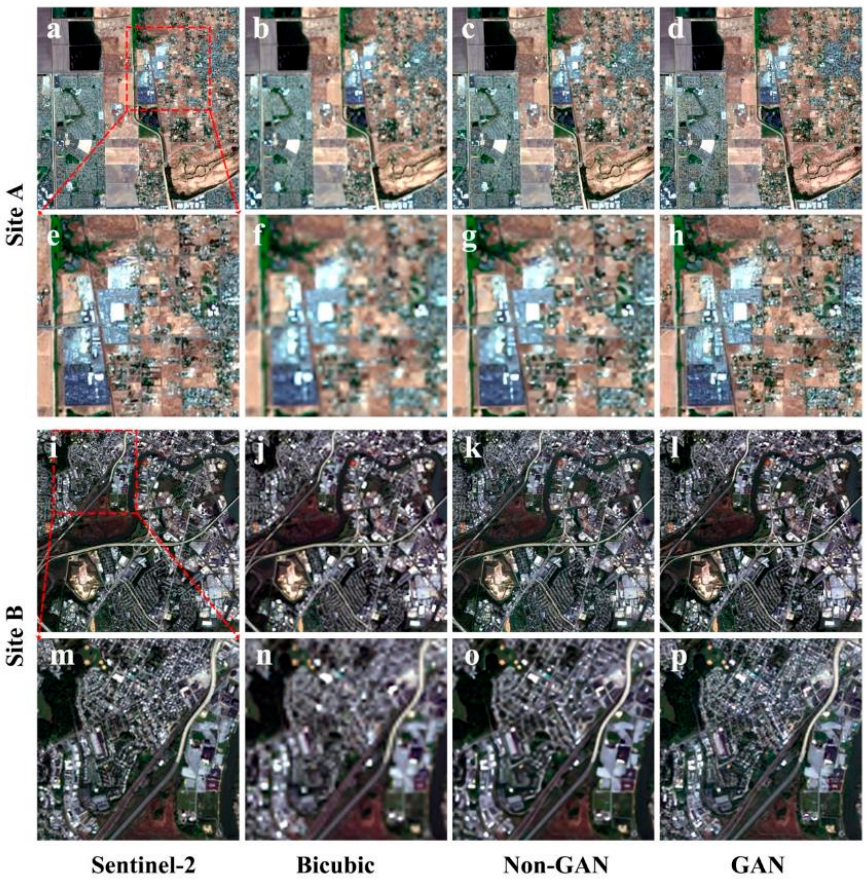
Figure 5. Super-resolution results in the simulated data experiment. From left to right: original Sentinel-2, interpolated, non-GAN derived, and GAN derived images at site A ( a – h ) and site B ( i – p ). For site A, ( e – h ) are shown as the zoomed-in comparison of ( a – d ); for site B, ( m – p ) are shown as the zoomed-in comparison of ( i – l ).